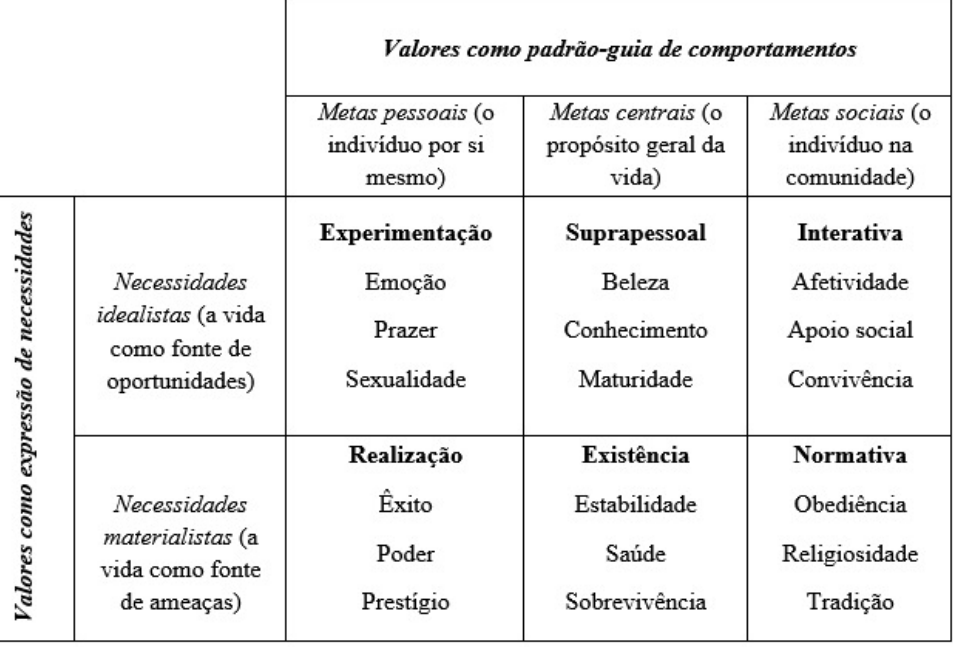
Figura 1 . Funções, subfunções e valores especí fi